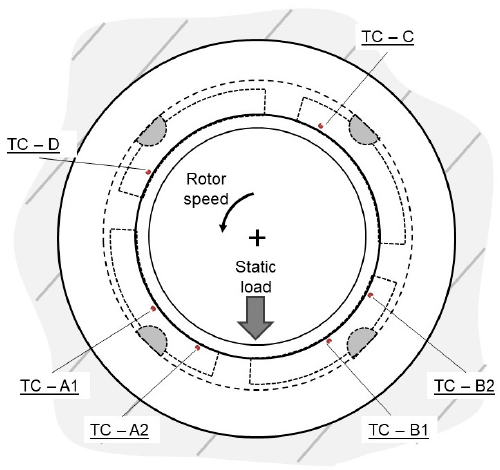
Figure 9. Flooded Ball & Socket Pivot bearing with thermocouples position.